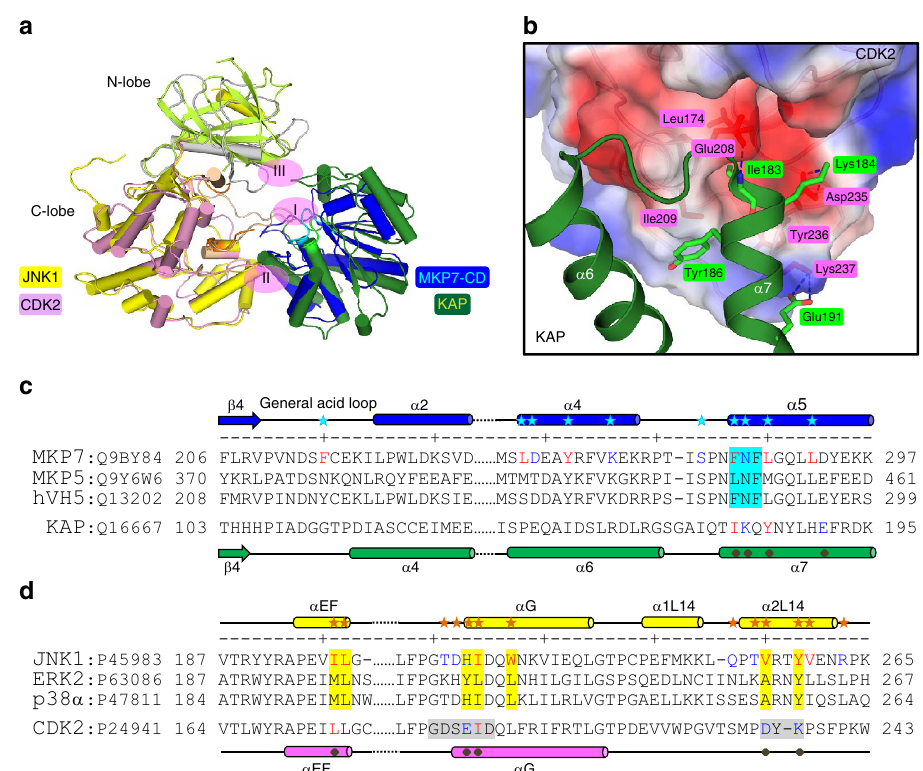
Figure 5 | Comparison of CDK2-KAP and JNK1–MKP7-CD. ( a ) Superposition of the complex structures of CDK2-KAP (PDB 1FQ1) and JNK1–MKP7-CD. The N-lobe and C-lobe of CDK2 are coloured in grey and pink, respectively, and KAP is coloured in green. The interactions between these two proteins consist of three discontinuous contact regions, centred at the multiple hydrogen bonds between the pThr160 of CDK2 and the active site of KAP (region I). Interestingly, the recognition of CDK2 by KAP is augmented by a similar interface as that observed in the complex of JNK1 and MKP7-CD (region II). ( b ) Interactions networks at the auxiliary region II mainly involving helix a 7 from KAP and the a G helix and following L14 loop of CDK2. The orientation of the panel is almost identical to those of Fig. 3d. The CDK2 is shown in surface representation coloured according to the electrostatic potential (positive, blue; negative, red). Residues of KAP and CDK2 are highlighted as green and red sticks, respectively. Blue dashed lines represent polar interactions. One remarkable difference between these two kinase-phosphatase complexes is that helix a 6 of KAP (corresponding to helix a 4 of MKP7-CD) plays little, if any, role in the formation of a stable heterodimer of CDK2 and KAP. ( c ) Sequence alignment of the JNK-interacting regions on MKPs. Residues of MKP7-CD involved in JNK1 recognition are indicated by cyan asterisks, and the conserved FXF-motif is highlighted in cyan. The secondary structure assignments of MKP7-CD and KAP are shown above and below each sequence. ( d ) Sequence alignment of the F-site regions on MAPKs. Residues of JNK1 involved in recognition of MKP7 are indicated by orange asterisks, and those forming the F-site are highlighted in